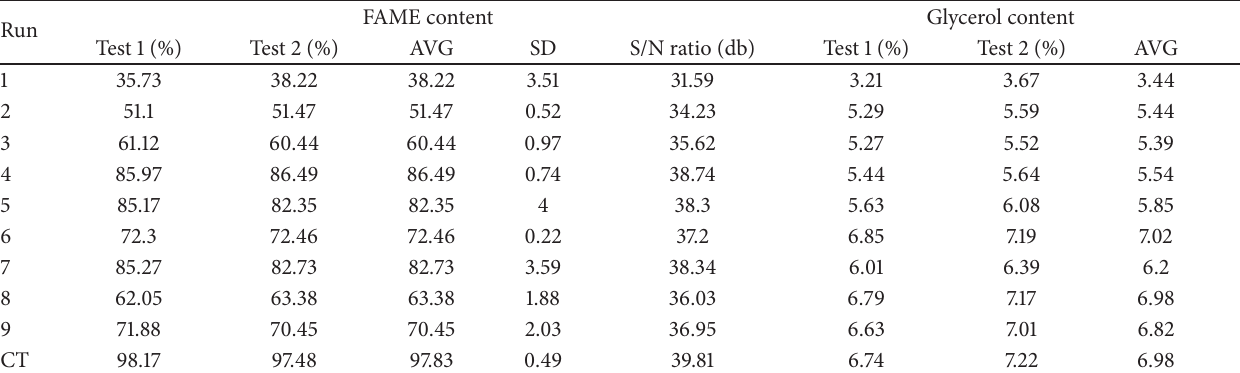
Table 4: Results of L9 (3 4 ) orthogonal array experiments on fatty acid methyl ester (FAME) and glycerol contents of biodiesel production samples.